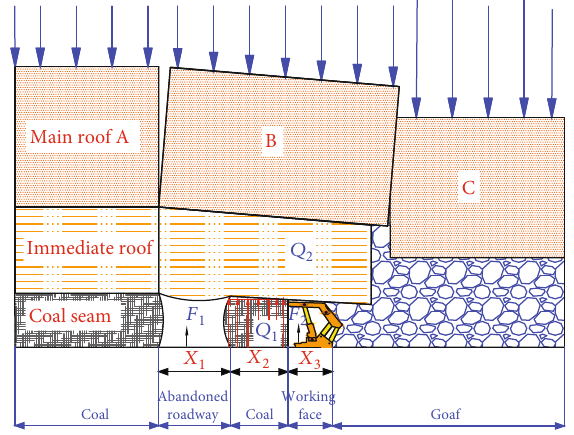
Figure 6: Schematic diagram of roadway crossing close to the abandoned